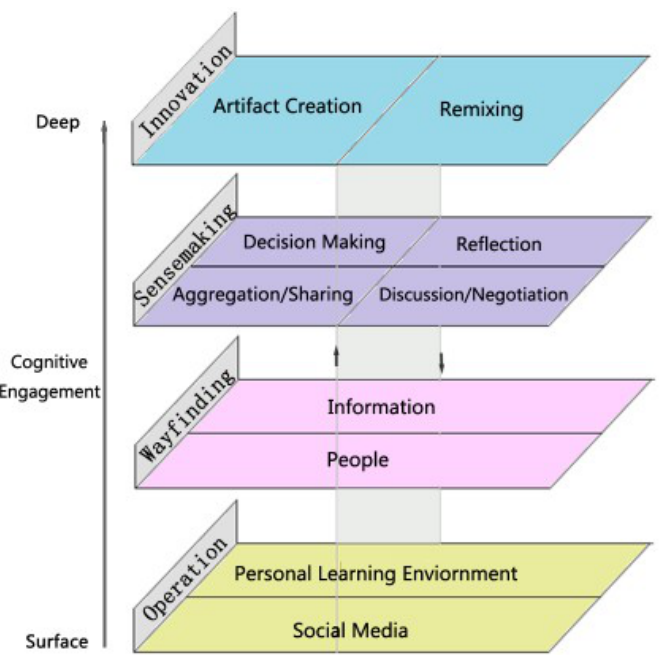
Figure 4. Framework for interaction and cognitive engagement in connectivist